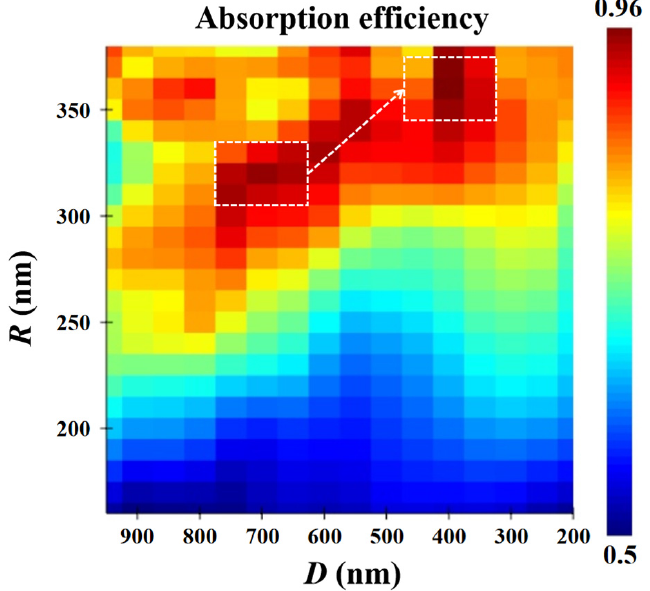
Figure 3. Two-dimensional maps of the absorption efficiency in terms of hole depth and hole ra- µ dius at λ = 1.31 μ m. at λ = 1.31